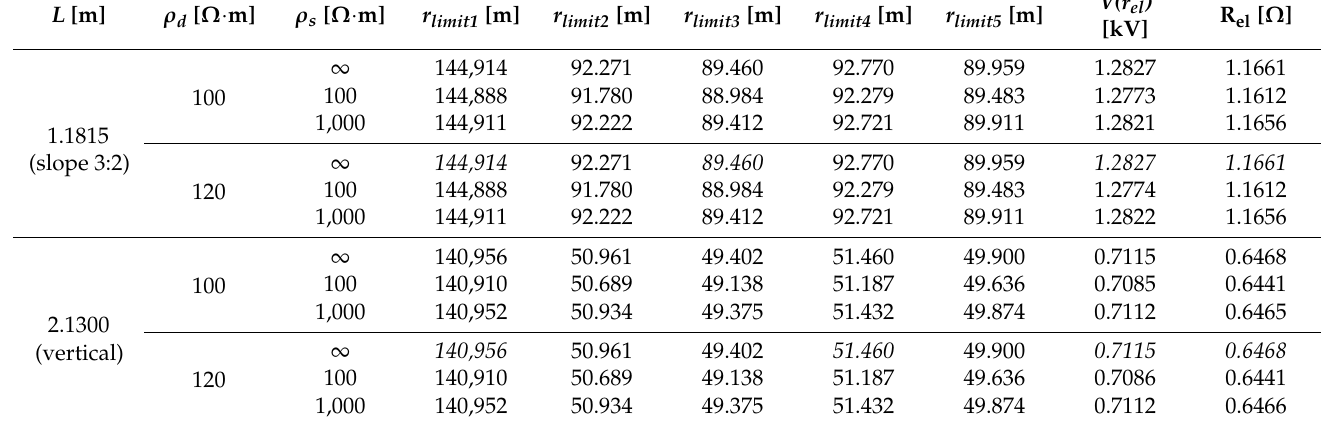
Table 7. Minimum values of distances for absolute potential in relation to remote earth, for potential gradient/electric field strength in steady and transient state, absolute potential at electrode surface and equivalent electrode resistance in the area of Korakia (Crete) in relation to neighboring coasts based on the method “A” according to Equations (53) and (54),